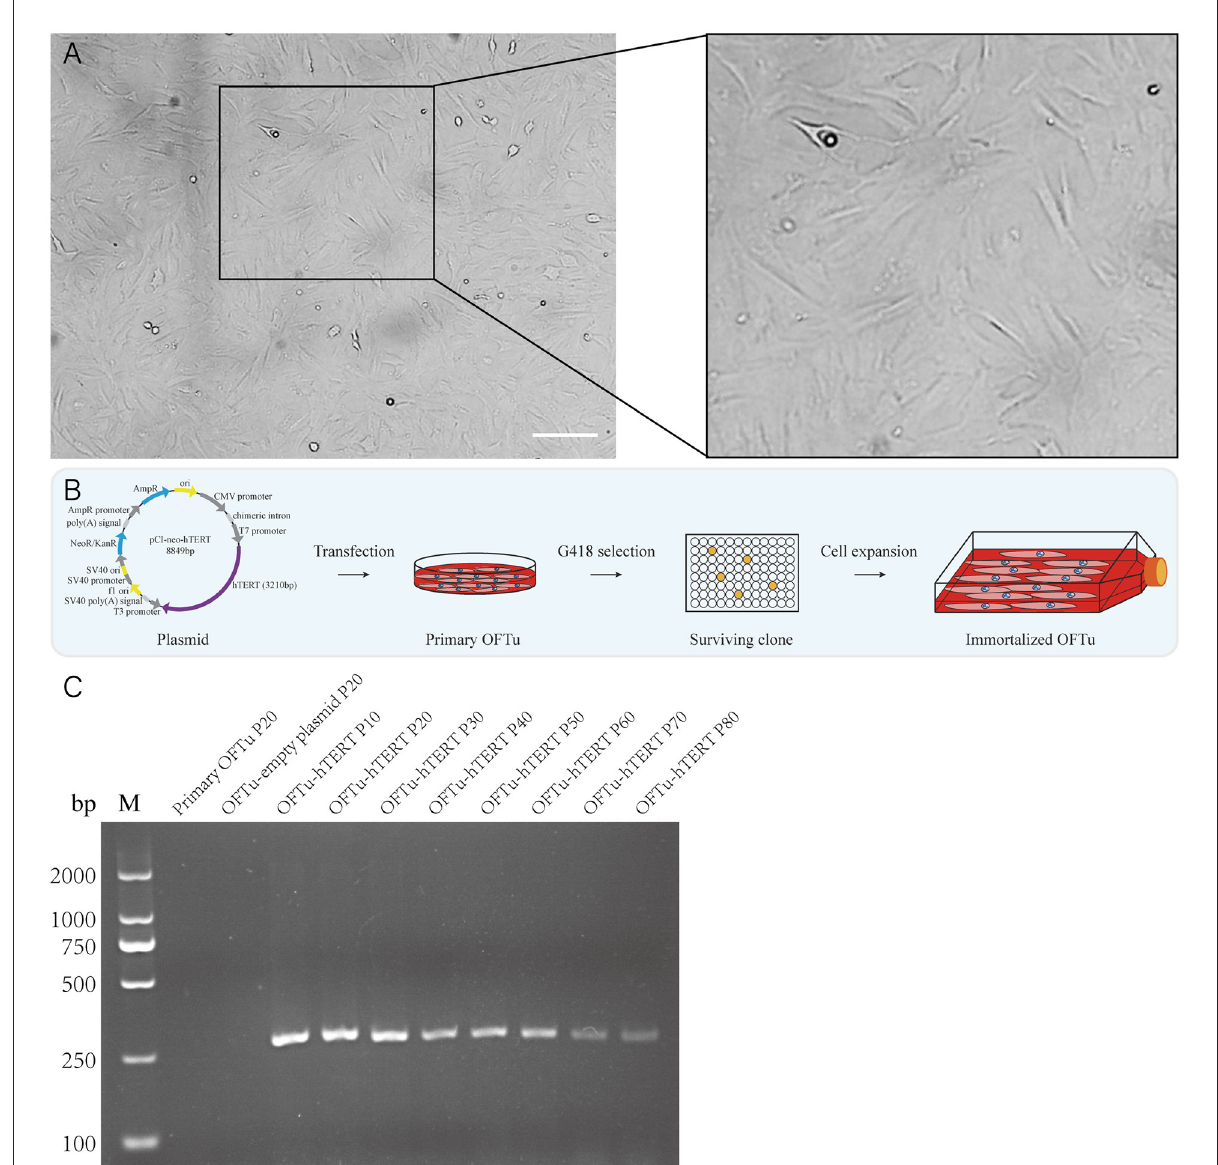
FIGURE1 Generation of the OFTu cell line stably expressing hTERT . (A) Typical cell morphology of OFTu under phase contrast microscope. Scale bar = 100 µ m. (B) Schematic overview to generate immortalized OFTu cell line expressing hTERT . (C) The hTERT gene transcripts were amplified from primary OFTu (lane 1), empty plasmid-transfected OFTu (lane 2) and hTERT -transfected OFTu (lane 3–10) by RT-PCR at several